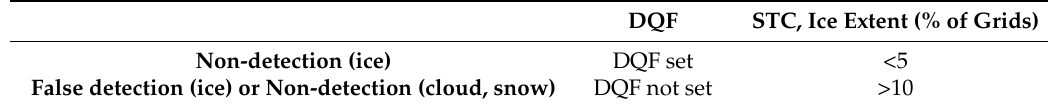
Table 1. The validation criteria for the STC algorithm is a comparison of areal river ice extents